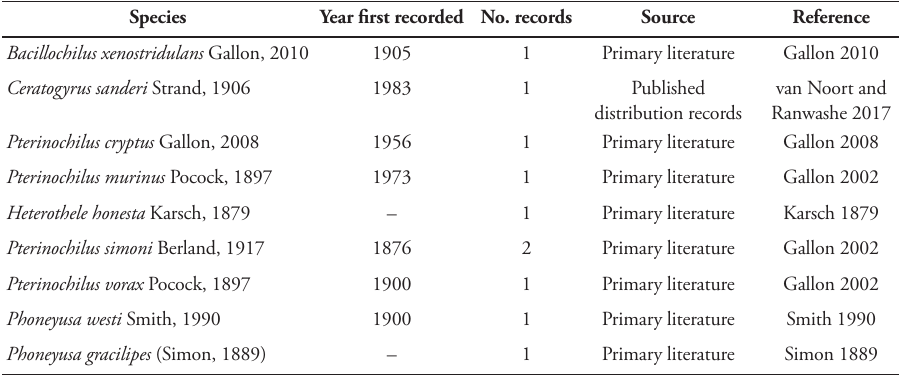
Table 1. Species of baboon spiders (Araneae: Theraphosidae) currently known from Angola, based on the primary taxonomic literature. Species with a dash (–) for Year Collected do not have collection event data associated with the specimen